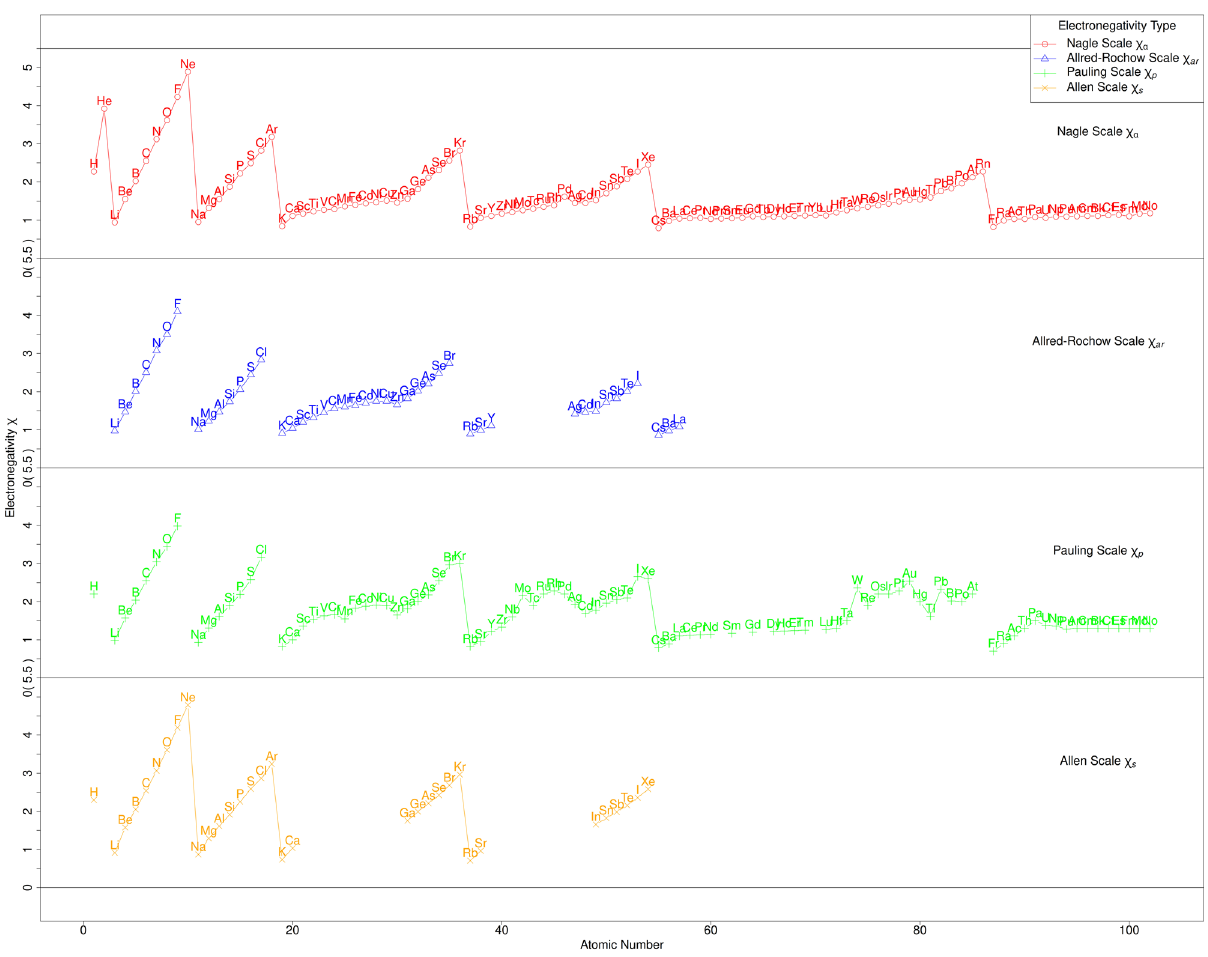
Figure 3: Changing trends of four electronegativity scales.